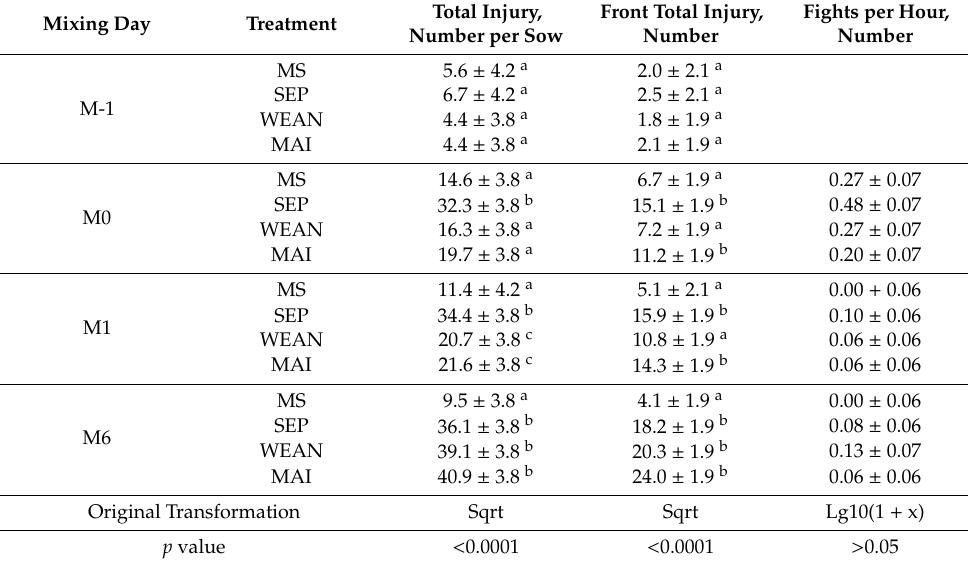
Table 2. Interaction between days after mixing and treatment on measures linked to aggression in sows 1,2 .